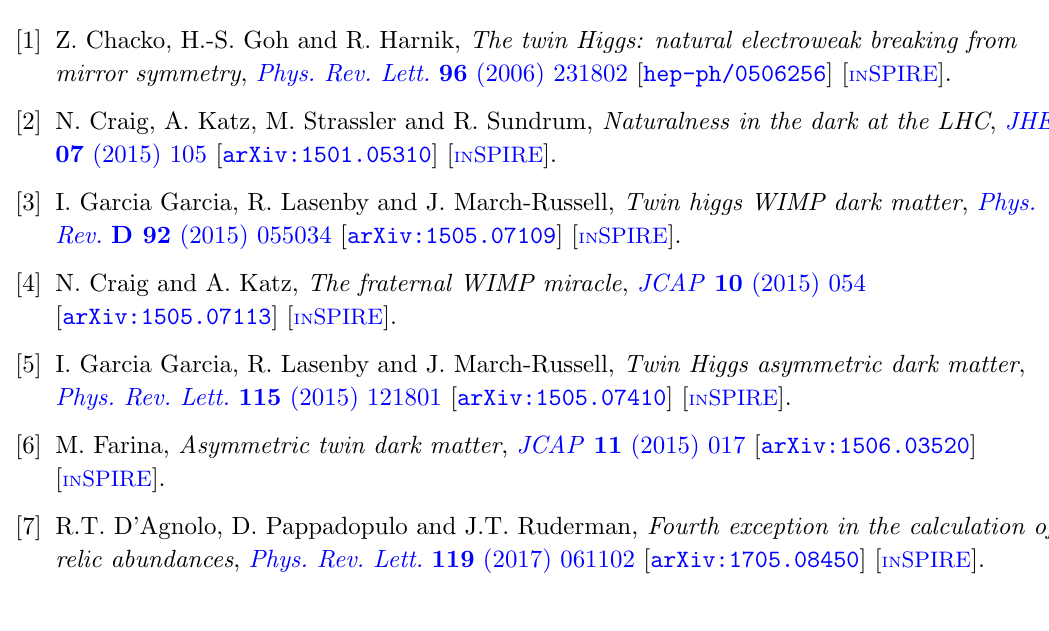
JHEP09(2018)098